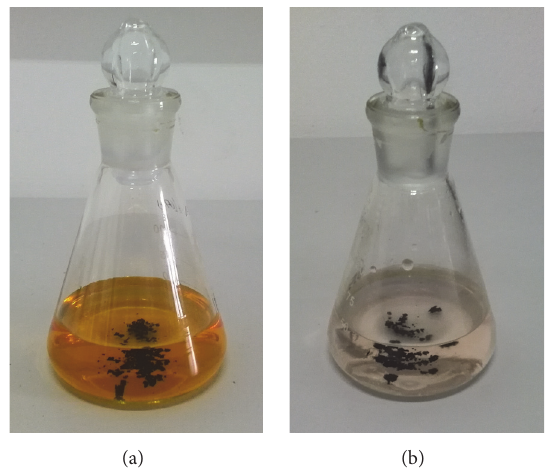
Figure 6: Adsorption effect of 0.02 g CA4 in 50 mL 10mg/L methyl orange solution for 72 h ((a) before adsorption and (b) after adsorption).